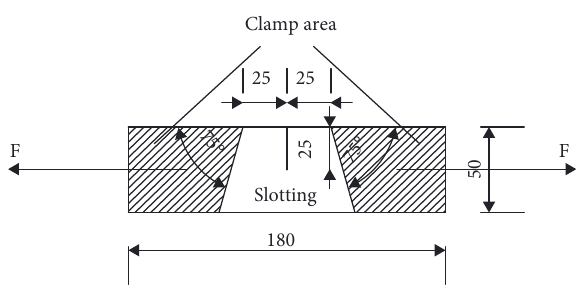
Figure 3: Specimen dimension of tearing tests